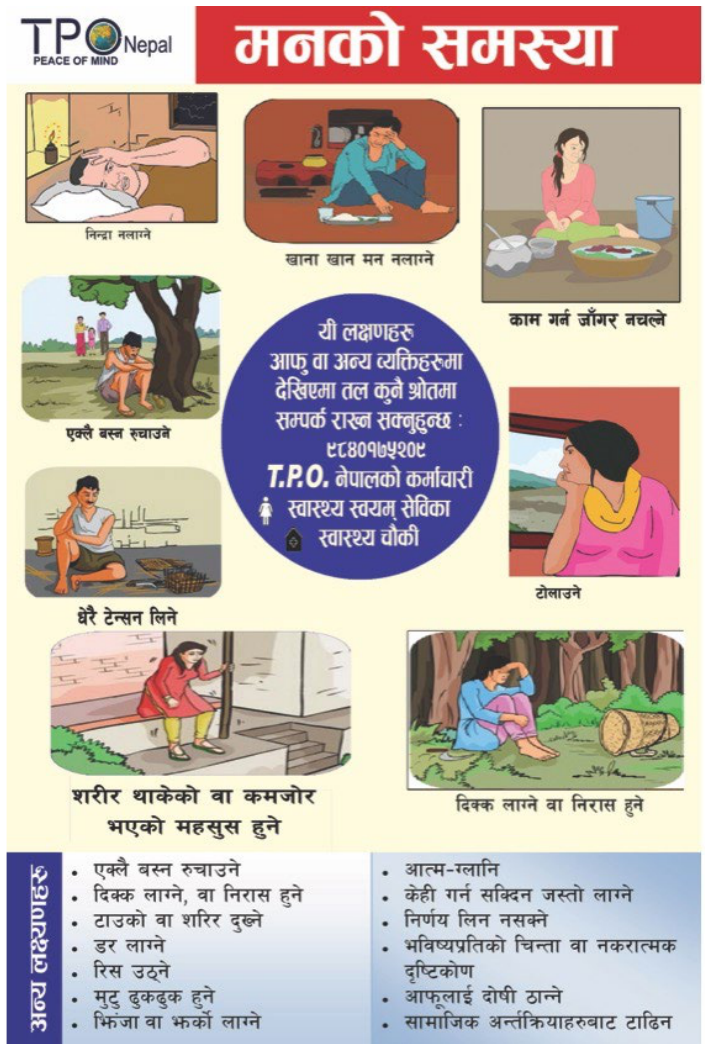
Figure 1. An ‘Information, Education and Communication’ handout publicly available in the resources section of TPO-Nepal’s website (Retrieved 15 September 2019 from http://tponepal.org/category/iec-materials/; designed and published in Nepal and reproduced